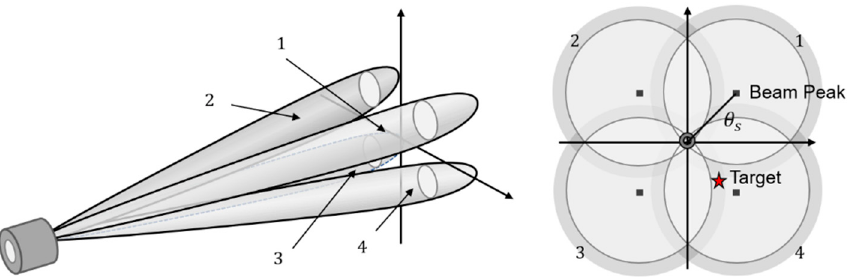
Figure 1. Beam pattern of a monopulse radar.